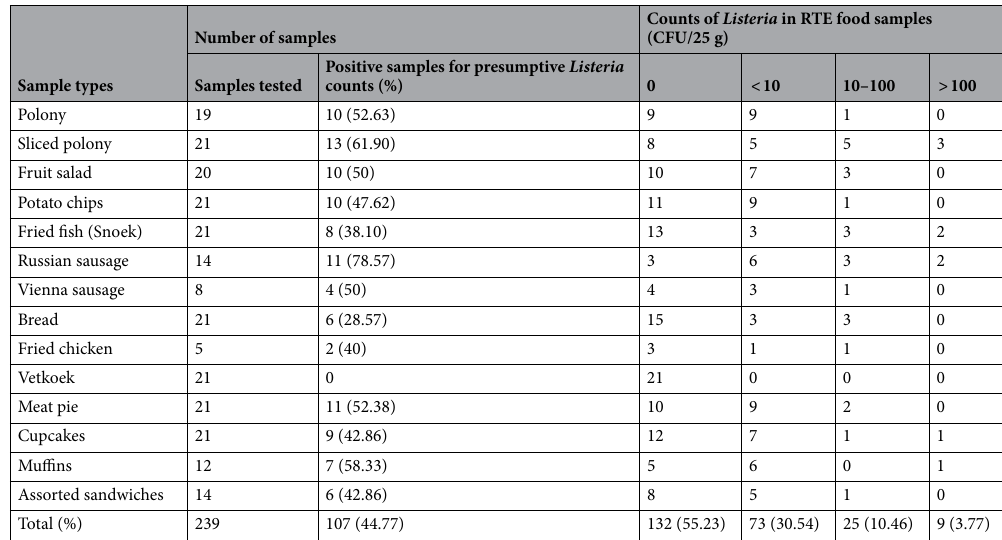
Table 1. Presumptive aerobic plate counts of Listeria and contamination levels of RTE food samples analyzed. Contamination is higher (p < 0.01) in specific RTE food (sliced polony, potato chips, fried fish, bread, meat pie, Russian sausages, and cupcake).